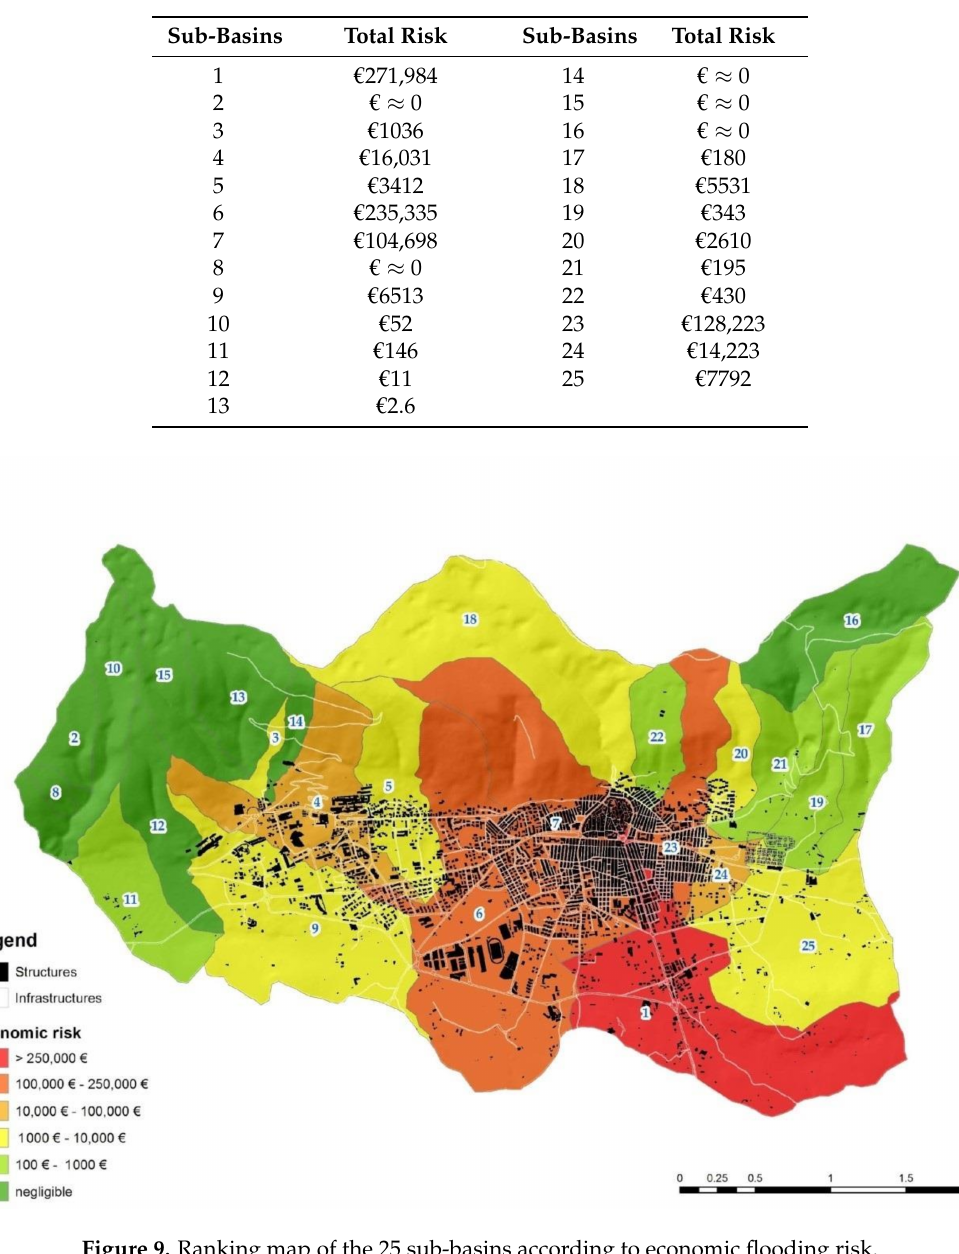
Table 5. Total risk for sub-basins.